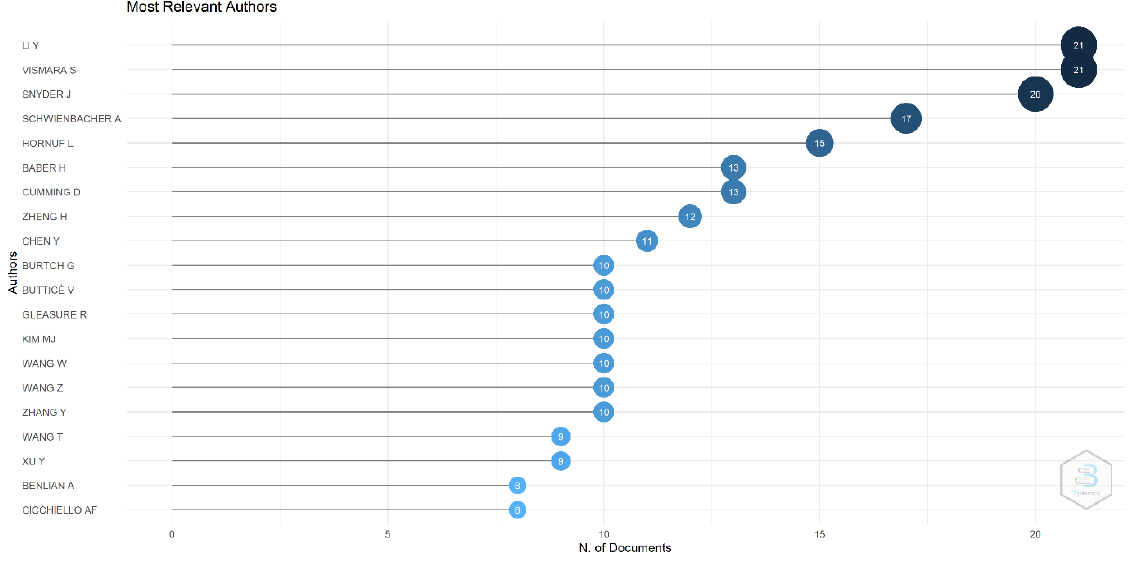
Figure 3. Authors’ number of